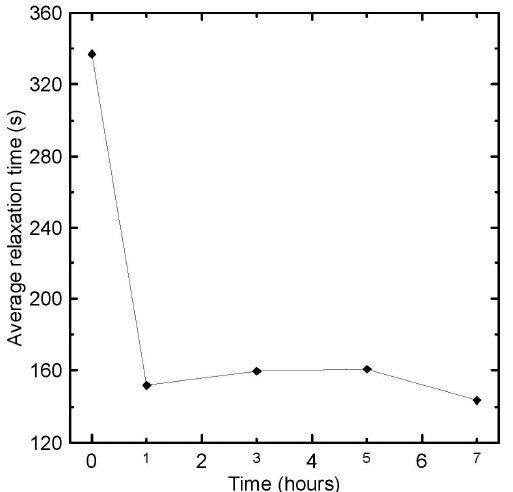
Figure 5. Average relaxation time, calculated via Equation (16) by using discontinues relaxation spectra, plotted as the function of degradation time for investigated polypropylene at 180 °C.